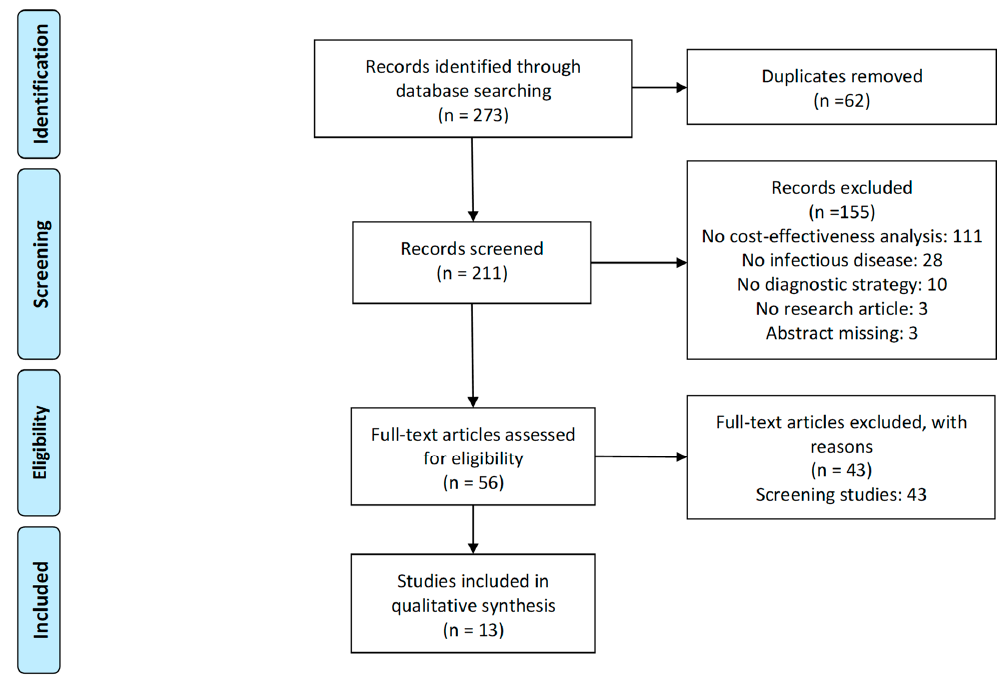
Figure 1. PRISMA flow diagram.